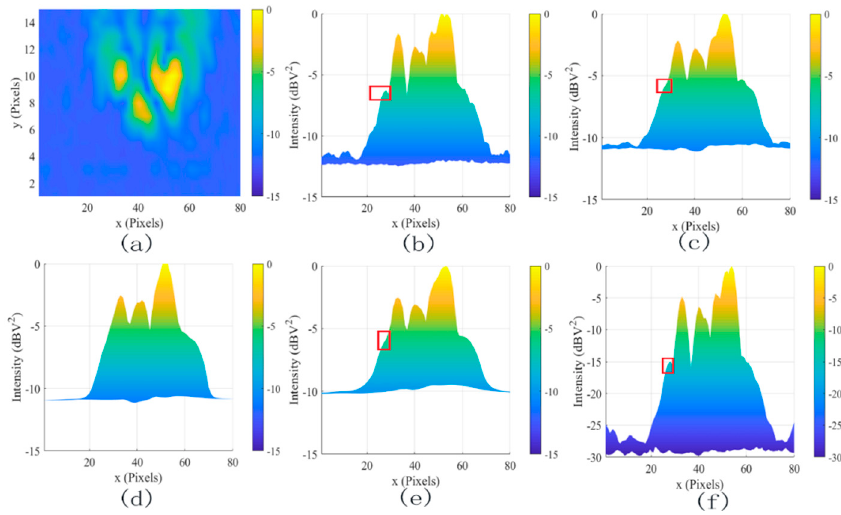
Figure 11. The filtered results for two horn antennas at 3 GHz. ( a ) The original image, ( b ) the lateral view of (a), ( c ) SDC, ( d ) MLG, ( e ) SAM, and ( f ) proposed.